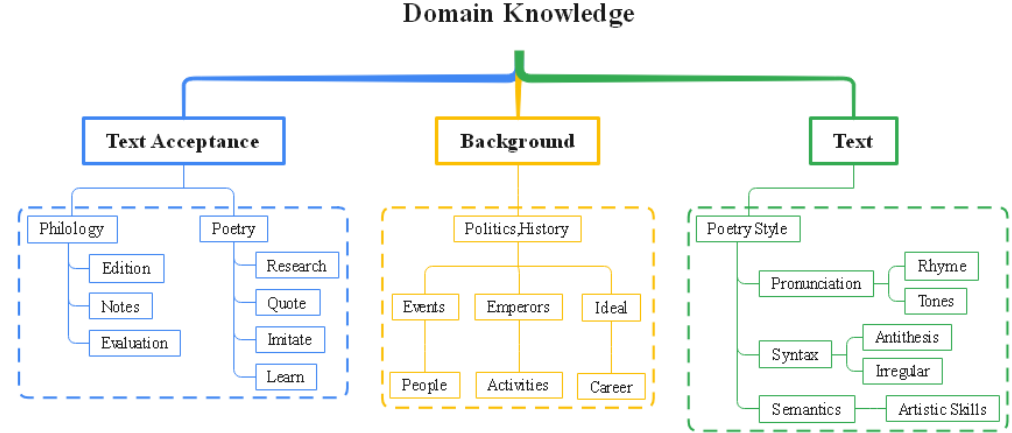
Figure 5. Description of domain knowledge for poetry in the Tang Dynasty.